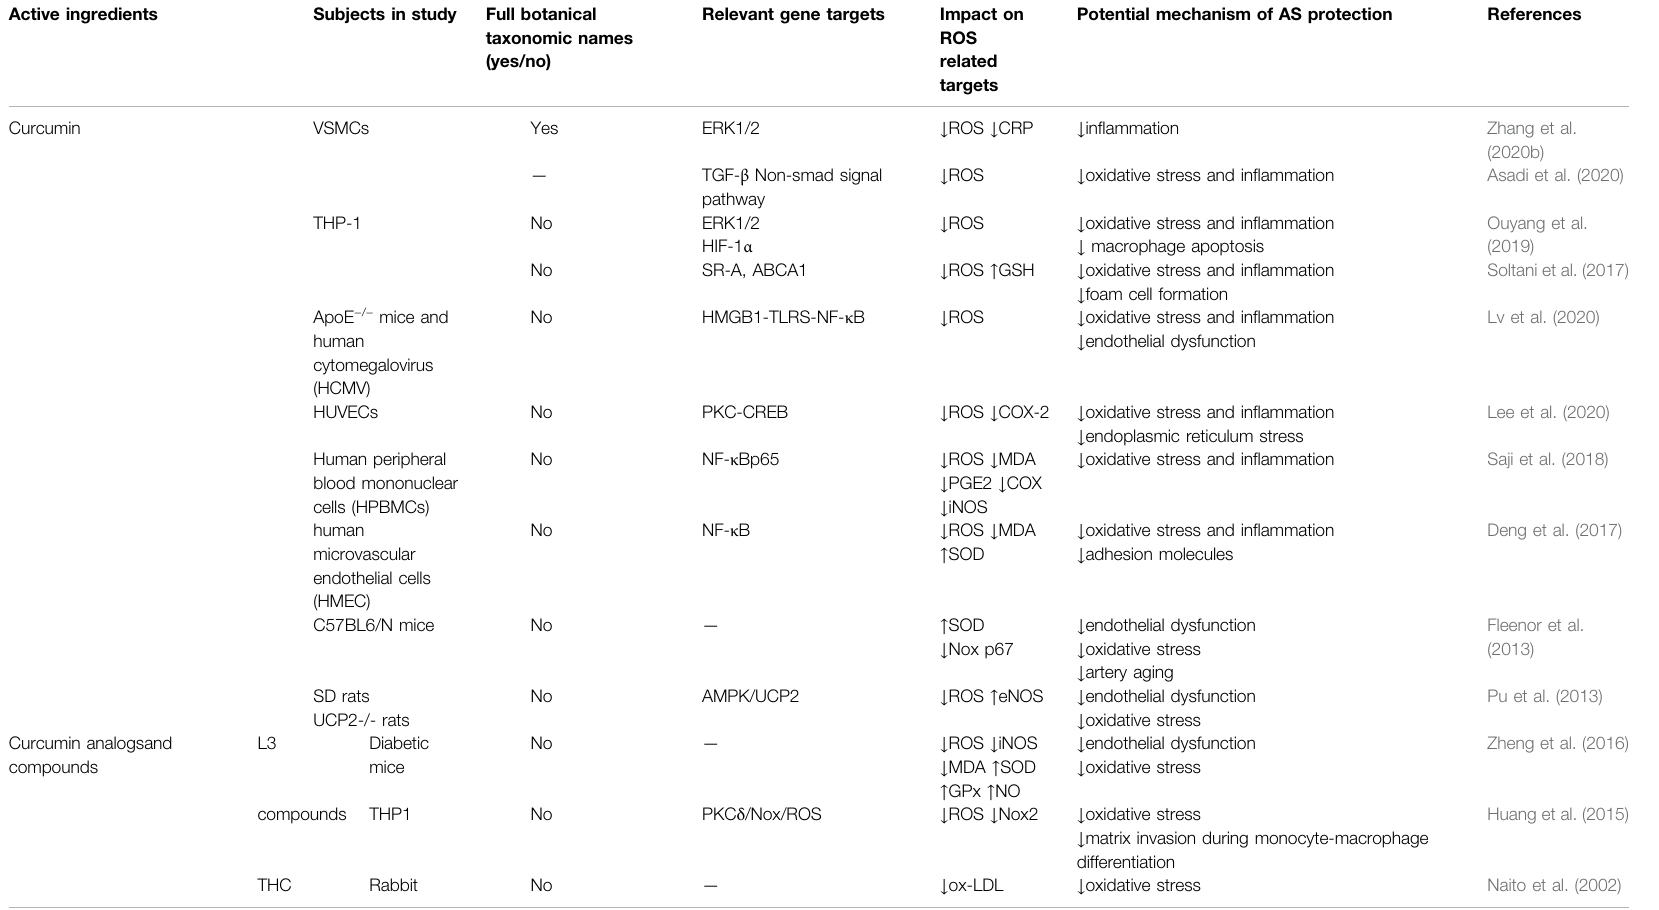
TABLE 2 | Curcumin and its analog for treatment of atherosclerosis by regulating oxidative stress. Active